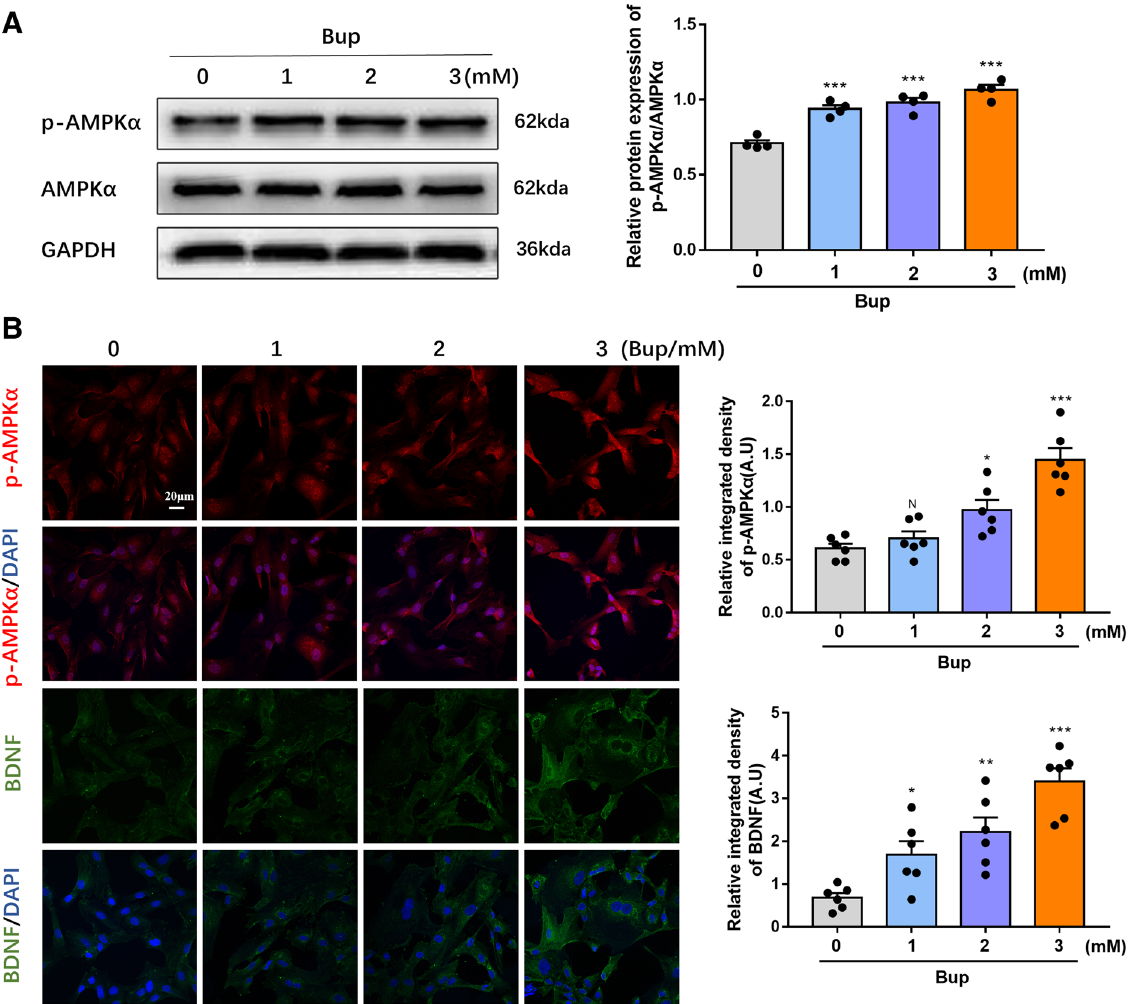
Figure 3. Bupivacaine activated AMPK protein in astrocytes. ( A ) Representative western blotting of p-AMPKα and AMPKα, and the ratio of p-AMPKα to total AMPK. ( B ) Immunofluorescence staining of p-AMPKα and BDNF in astrocytes after bupivacaine exposure. * p < 0.05, ** p < 0.01, *** p < 0.001 vs. the control group. Data are expressed as the mean ± SEM. Original images of gels/blots are available in Supplementary Fig